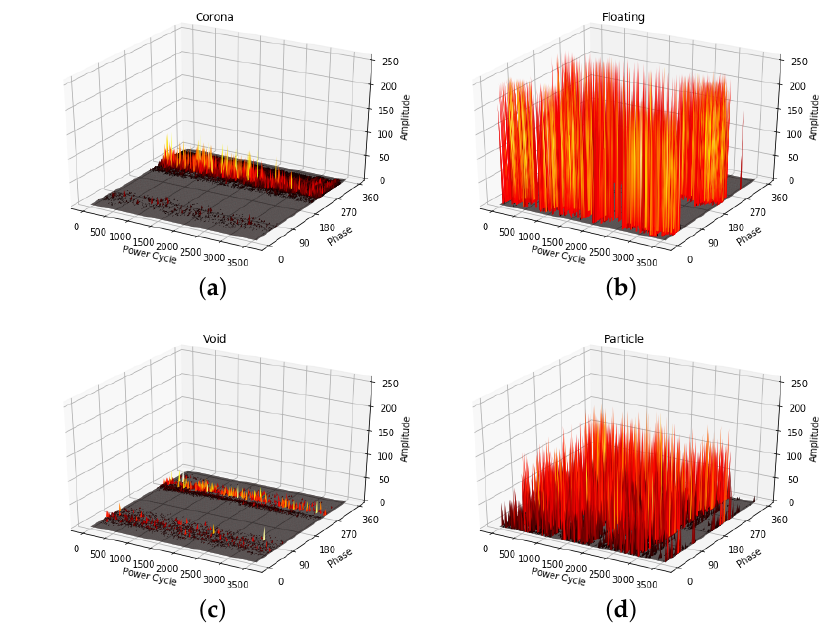
Figure 2. Phase-resolved PD (PRPD) fault types in the GIS: ( a ) corona, ( b ) floating, ( c ) void, and ( d ) particle faults.